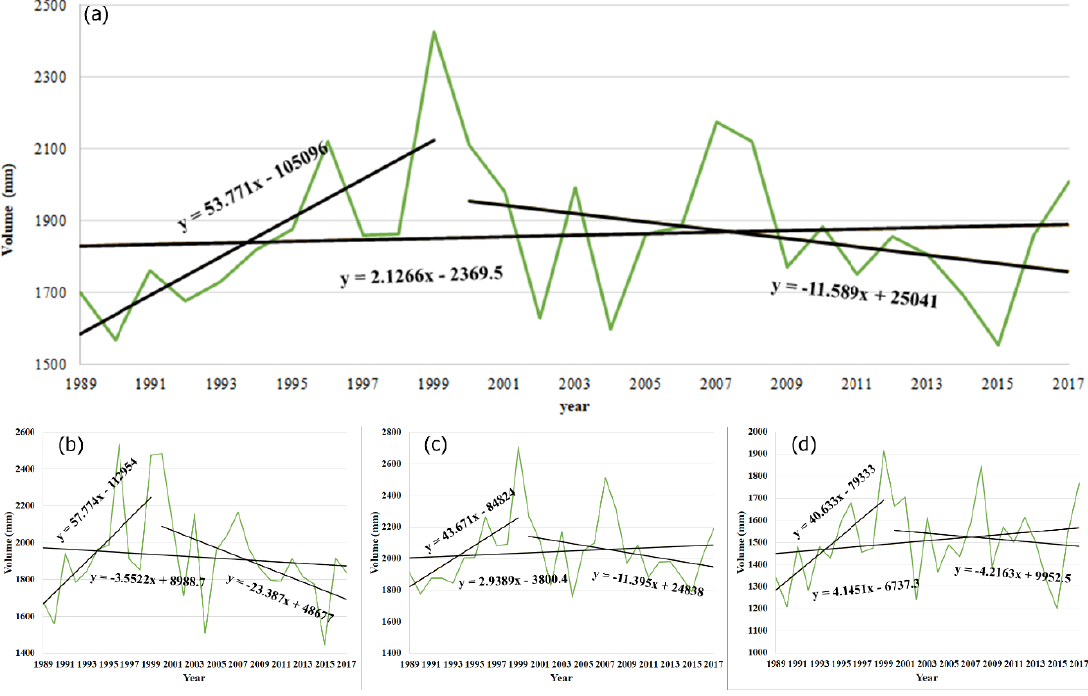
Figure 7. Trends in annual rainfall patterns from 1989 to 2017: ( a ) the study area, ( b ) LXQ, ( c ) CMP, and ( d ) the estuaries.